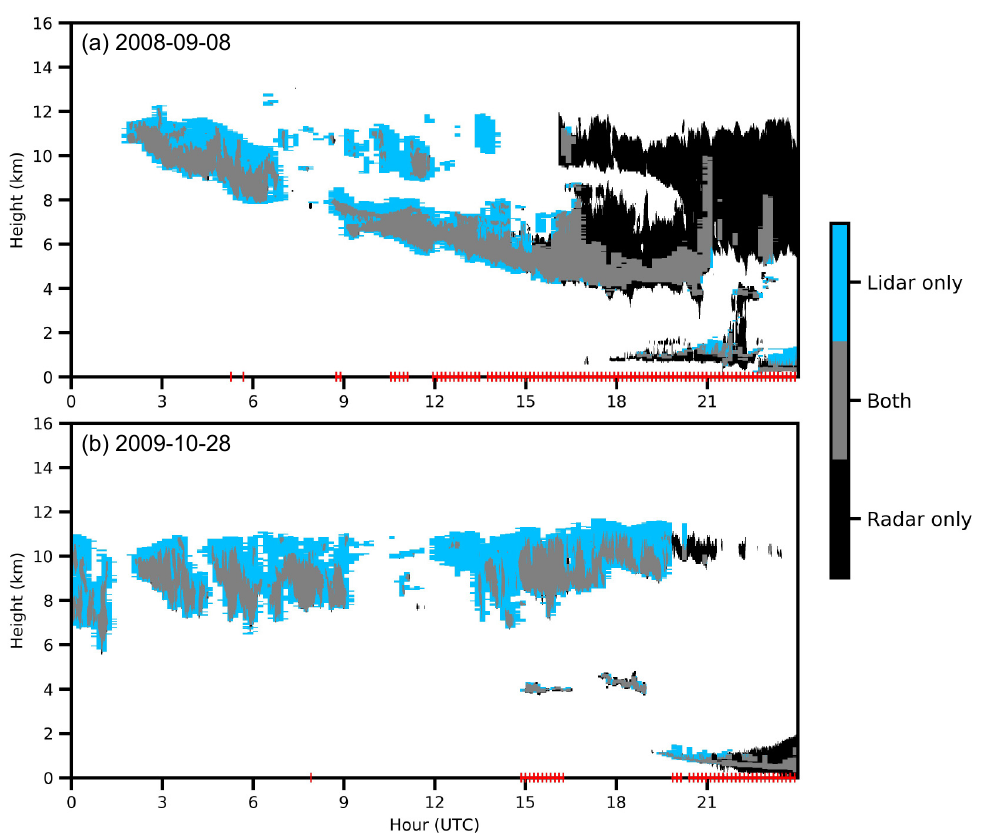
Figure 1. Raman lidar (RL) and millimeter wavelength cloud radar (MMCR) observations on ( a ) 8 September 2008 and ( b ) 28 October 2009 at the Southern Great Plains (SGP) site. The hydrometeors detected by the RL and MMCR are shown. The hydrometeors observed by both RL and MMCR (i.e., both) are shown in gray, those observed by RL only (i.e., lidar only) are shown in light blue, and those observed by MMCR only (i.e., radar only) are shown in black. The periods when the RL was fully attenuated are indicated as red “+” along the x-axis.